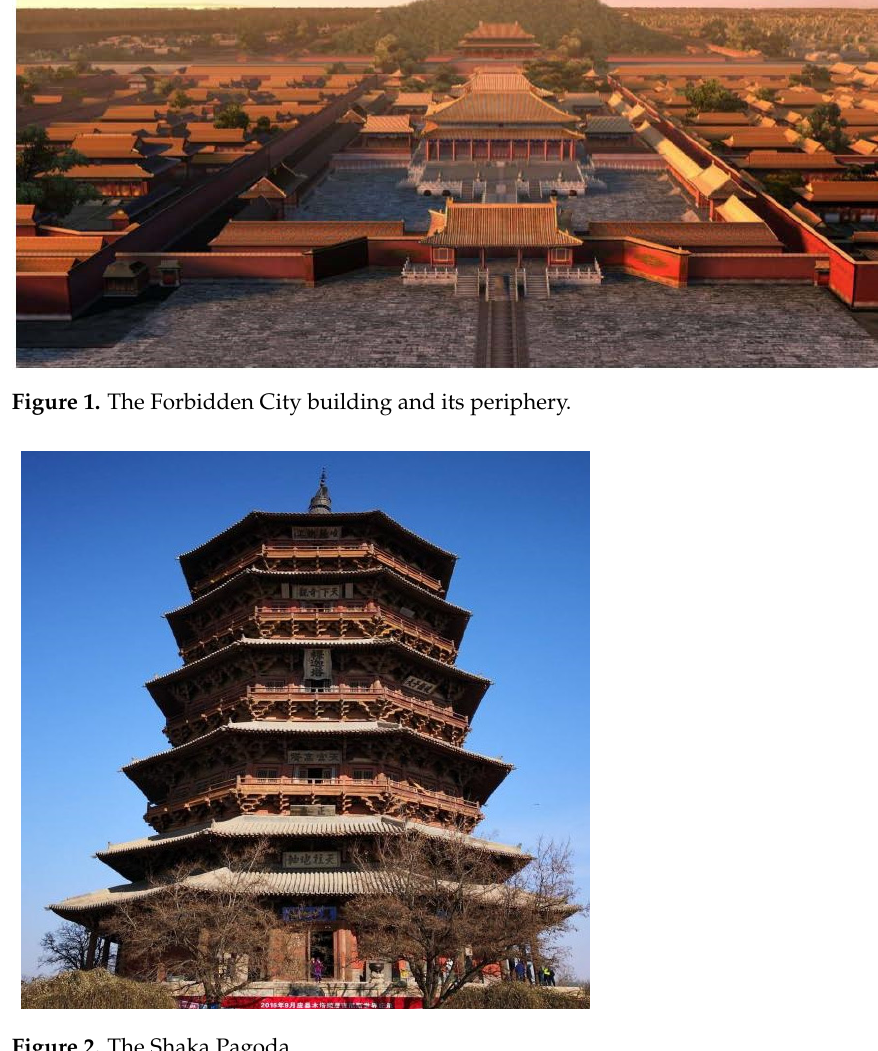
Figure 2. The Shaka Pagoda.